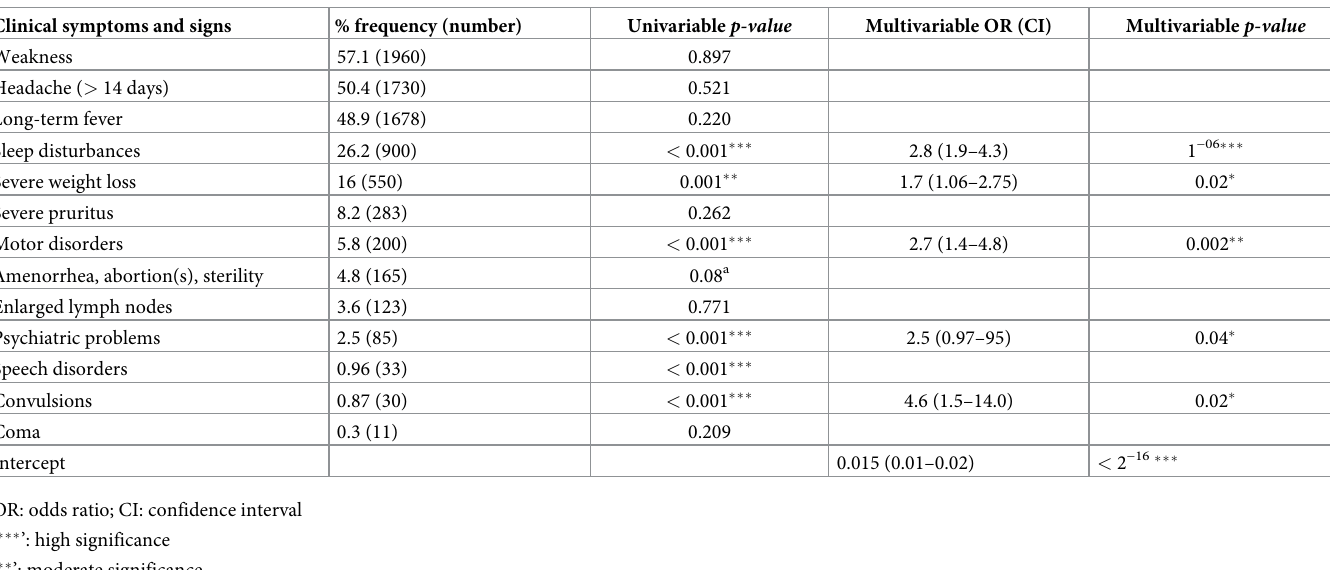
Table 1. Frequency of clinical symptoms and signs and their association with RDT positivity. Clinical symptoms and